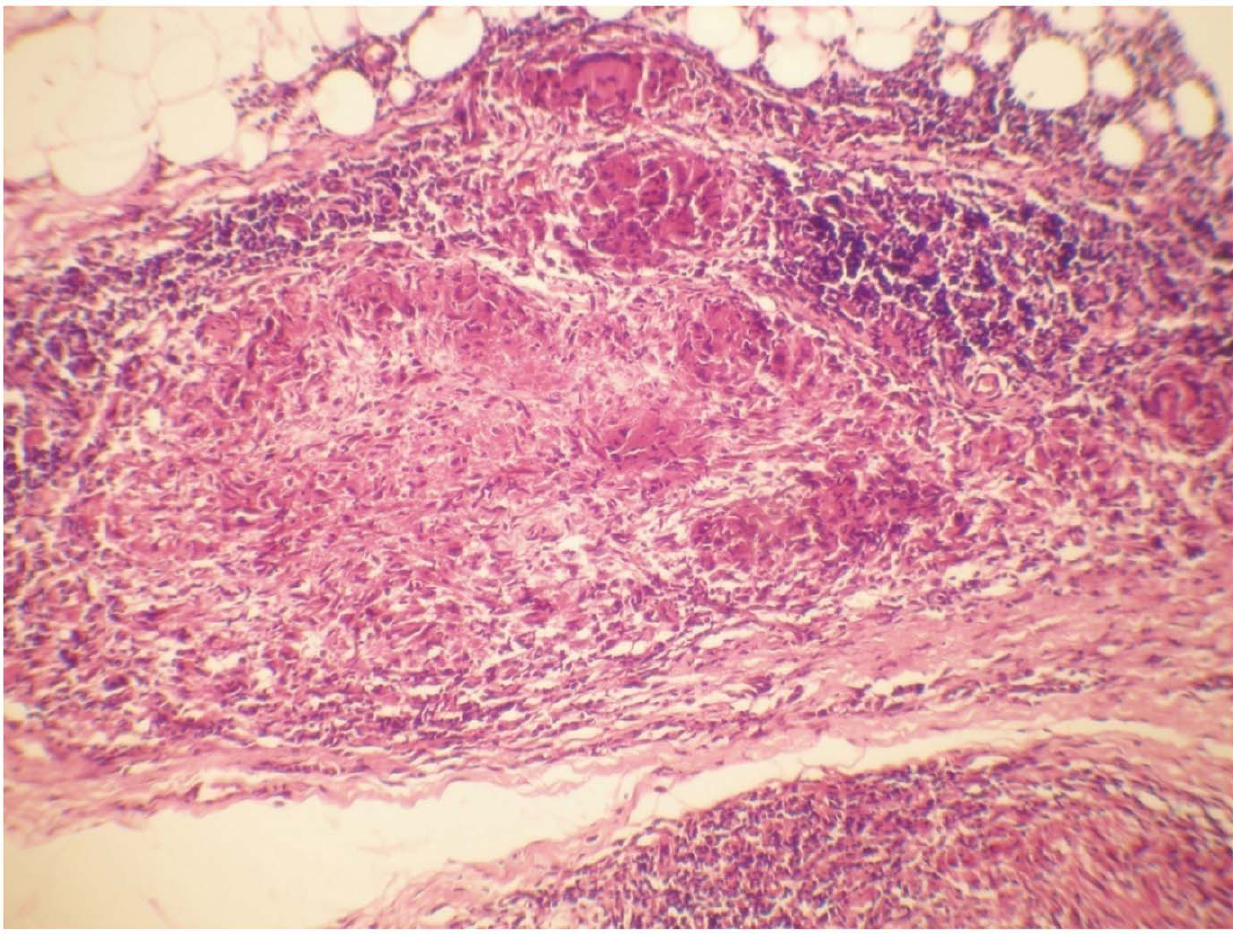
Figure 3. Delayed-type hypersensitivity in dermal nerve. Skin - BT in Type 1 Reaction showing aggressive DTH with epithelioid granuloma destroying a deep dermal nerve, areas of necrosis and focal lymphocytic response. H&E staining 6 20.